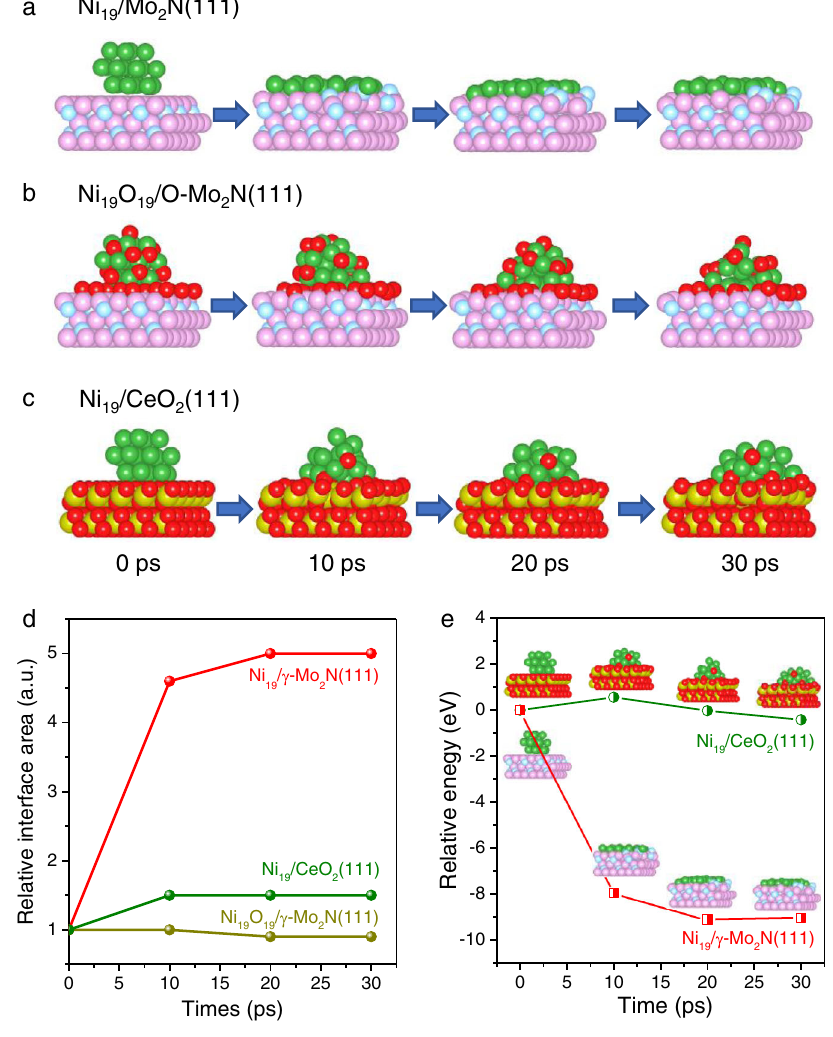
Fig. 1 The structure evolution of Ni NPs on varied supports at 590 °C in AIMD simulations. The structure evolution of a Ni 19 on γ -Mo 2 N(111) support, b Ni 19 O 19 on passivated γ -Mo 2 N (O-Mo 2 N(111)), c Ni 19 on CeO 2 support, d the relative interface area of Ni to surface atom of support as a function to time, Ni 19 / γ -Mo 2 N(111), Ni 19 /CeO 2 (111) and Ni 19 O 19 / γ -Mo 2 N(111) listed, the initial interface area of the models were taken as bench mark “ 1 ” . e the relative free energy change in the redispersion process of Ni 19 / γ -Mo 2 N(111) and Ni 19 /CeO 2 (111) in 30 ps. In this fi gure, the red, green, pink, light blue and golden atoms are O, Ni, Mo, N and Ce